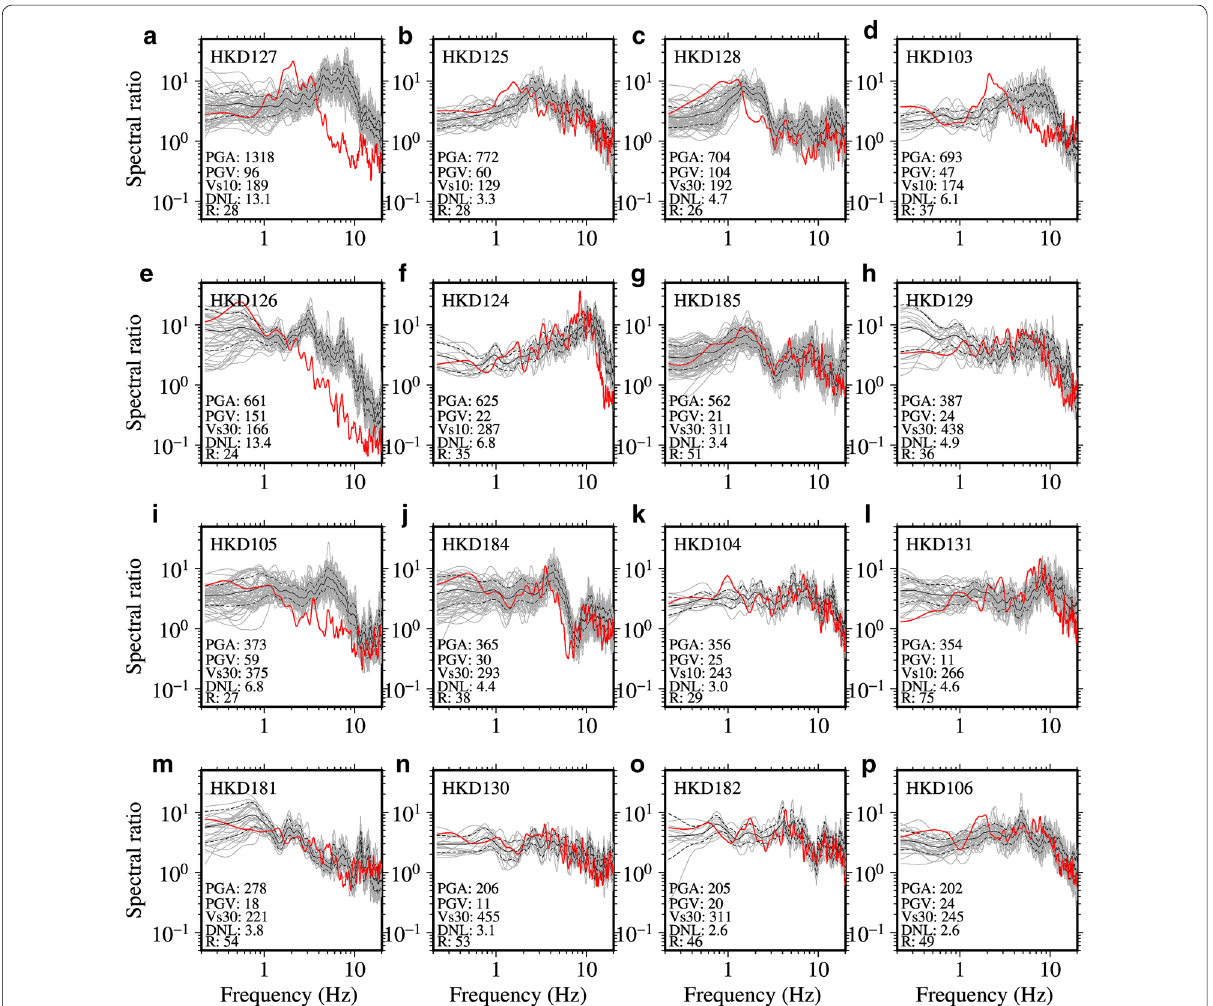
Fig. 14 Plots of H-to-V spectral ratios of surface recordings during weak-motions (gray lines) and those during the mainshock (red lines) at K-NET sites. See Fig. 3 for site location. The plots are arranged in order of decreasing horizontal vector PGAs in panels a – p , respectively. Solid black line denotes mean spectral ratios for weak-motions, and dashed gray lines denote one standard deviation. The horizontal vector PGA in units of cm/s 2 , horizontal vector PGV in units of cm/s, Vs30 in units of m/s, DNL values, and fault-to-site distance ( R ) in units of km are also included for each